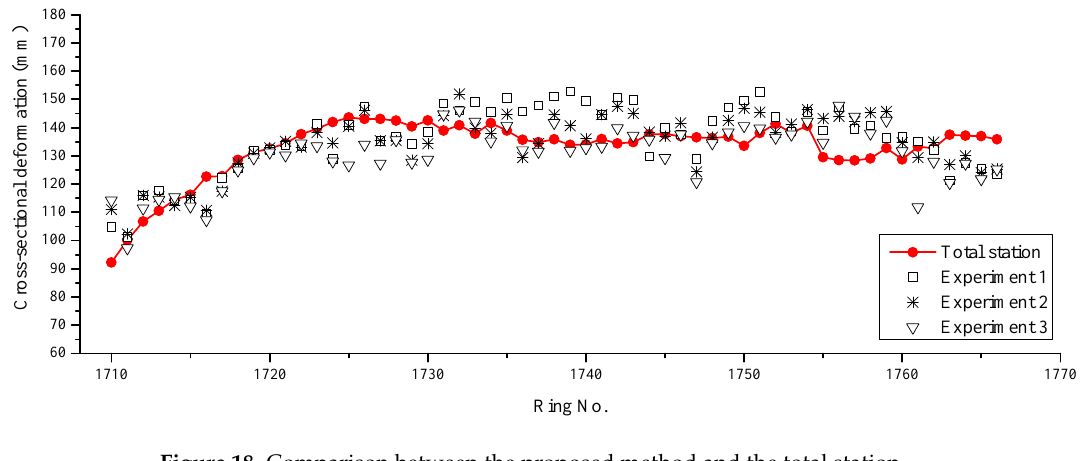
Figure 18. Comparison between the proposed method and the total station. Table 2. Statistics of the discrepancies of the proposed